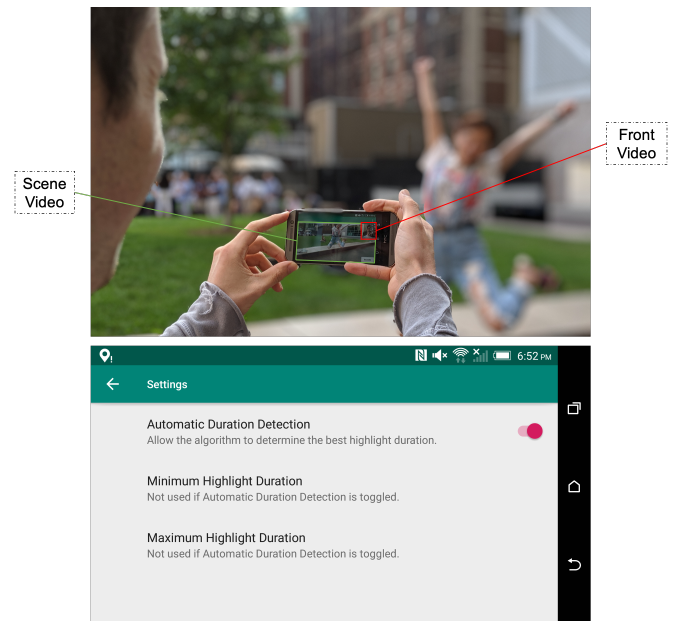
Figure 15. Application 1: photo of the application in use ( up ) and screenshot of the application settings menu ( down